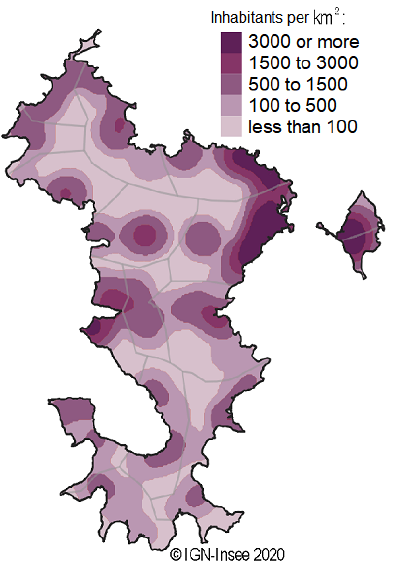
Figure 1. Density map of Mayotte from IGN-Ensee